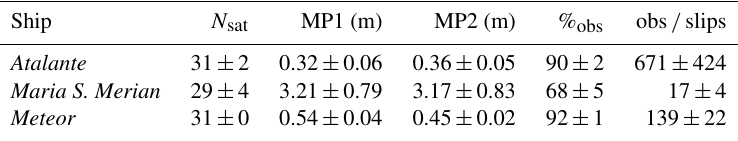
Table 2. Quality check diagnostics of GNSS phase observations (GPS measurements only) for the period from day of year 18 to 50 in 2020 on board R/Vs Atalante , Maria S. Merian and Meteor . The diagnostics are obtained with TEQC software (Estey and Meertens, 1999). N sat is the average number of satellites per day; MP1 and MP2 are multipath combinations for L1 and L2 carriers; % obs is the percentage of complete observations (observed divided by the expected number of observations); obs / slips is the ratio between complete observations and the number of slips. All the numbers are given as daily means ± 1 standard